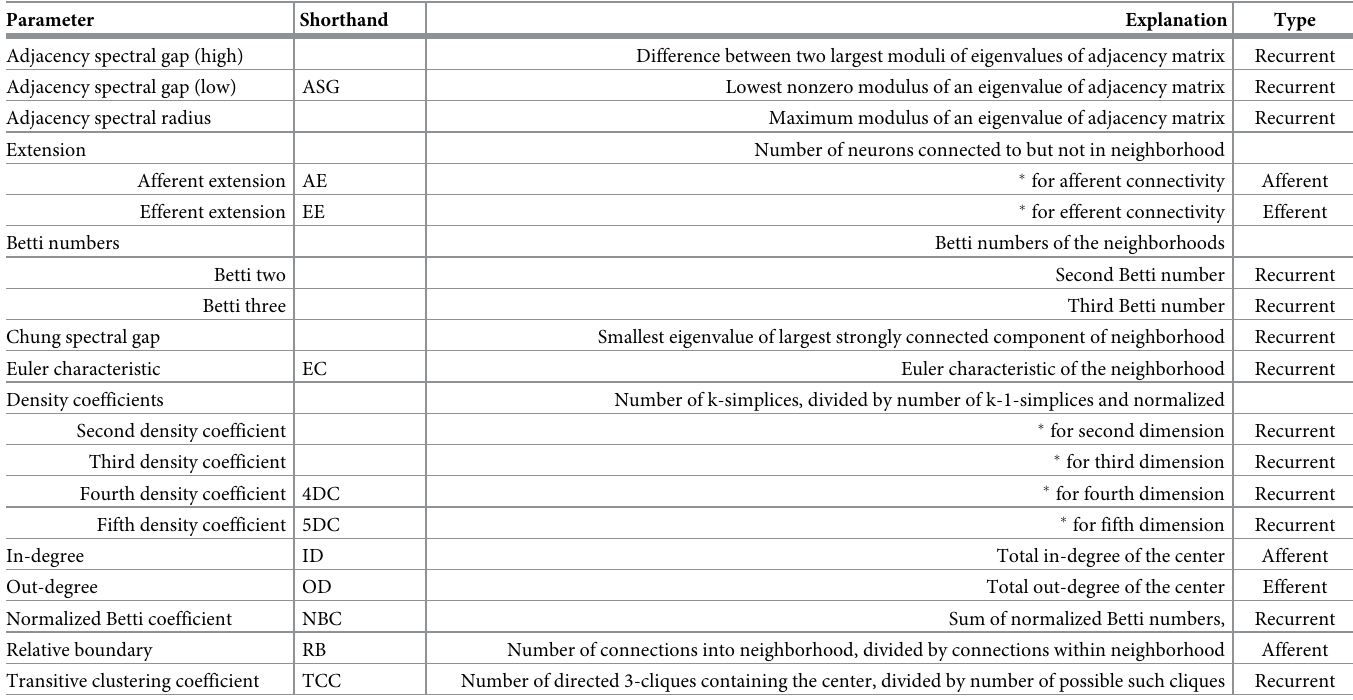
Table 1. Topological parameters